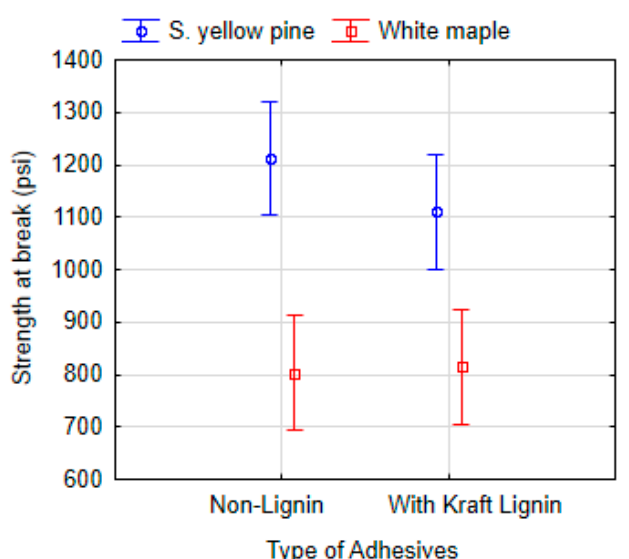
Figure 9. ANOVA of the dry shear strength at the break point according to the non-lignin adhesives (6 types: 10-SPI-PEO, 9-SPI-PEO, 9-SPI-HPMC, 9-SPI-C, 9-SPI-PVA, 15-SF-C) and the adhesives with added kraft lignin (6 types: 10-SPI-PEO-L, 9-SPI-PEO-L, 9-SPI-HPMC-L, 9-SPI-C-L, 9-SPI-PVA-L, 15-SF-C-L). Vertical bars denote 95% confidence interval.